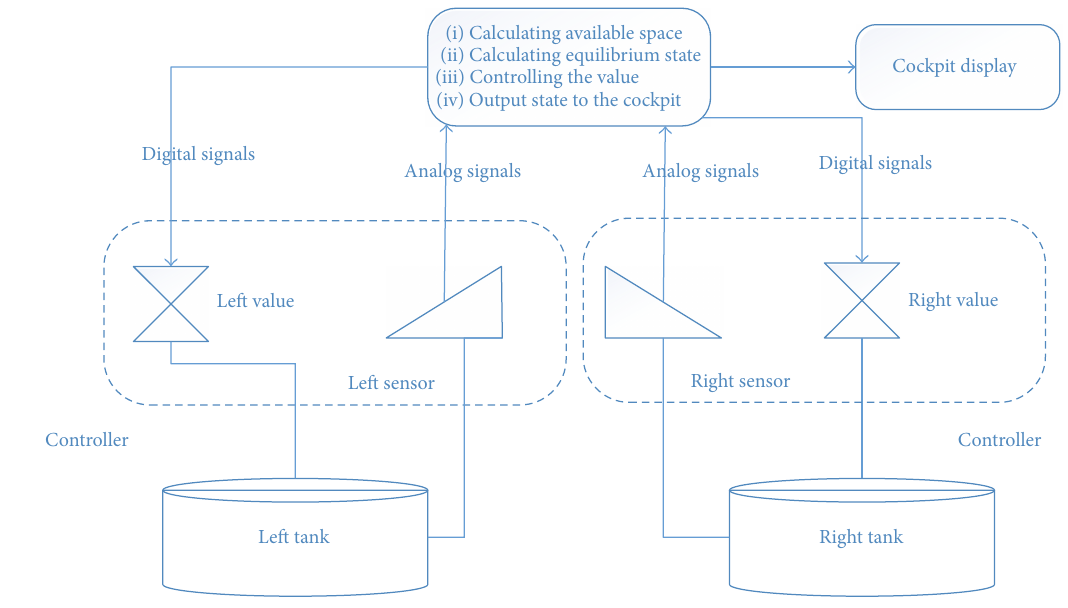
Figure 21: Physical structure of the water-and-waste system.